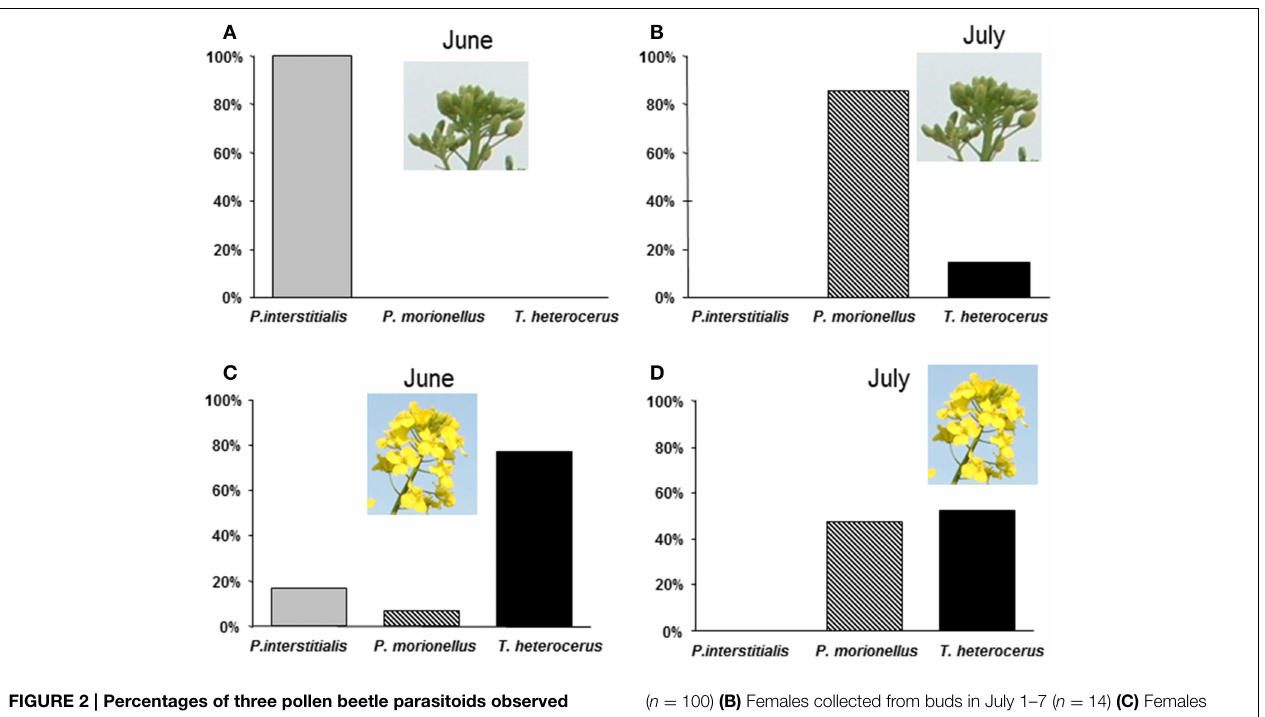
FIGURE 2 | Percentages of three pollen beetle parasitoids observed either on buds probing with ovipositor or observed in flowers independently of activity. (A) Females collected from buds, June 3–11